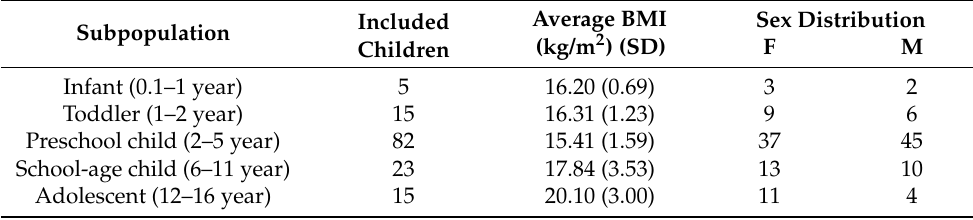
Table 2. Demographics of the included patients. Subpopulation